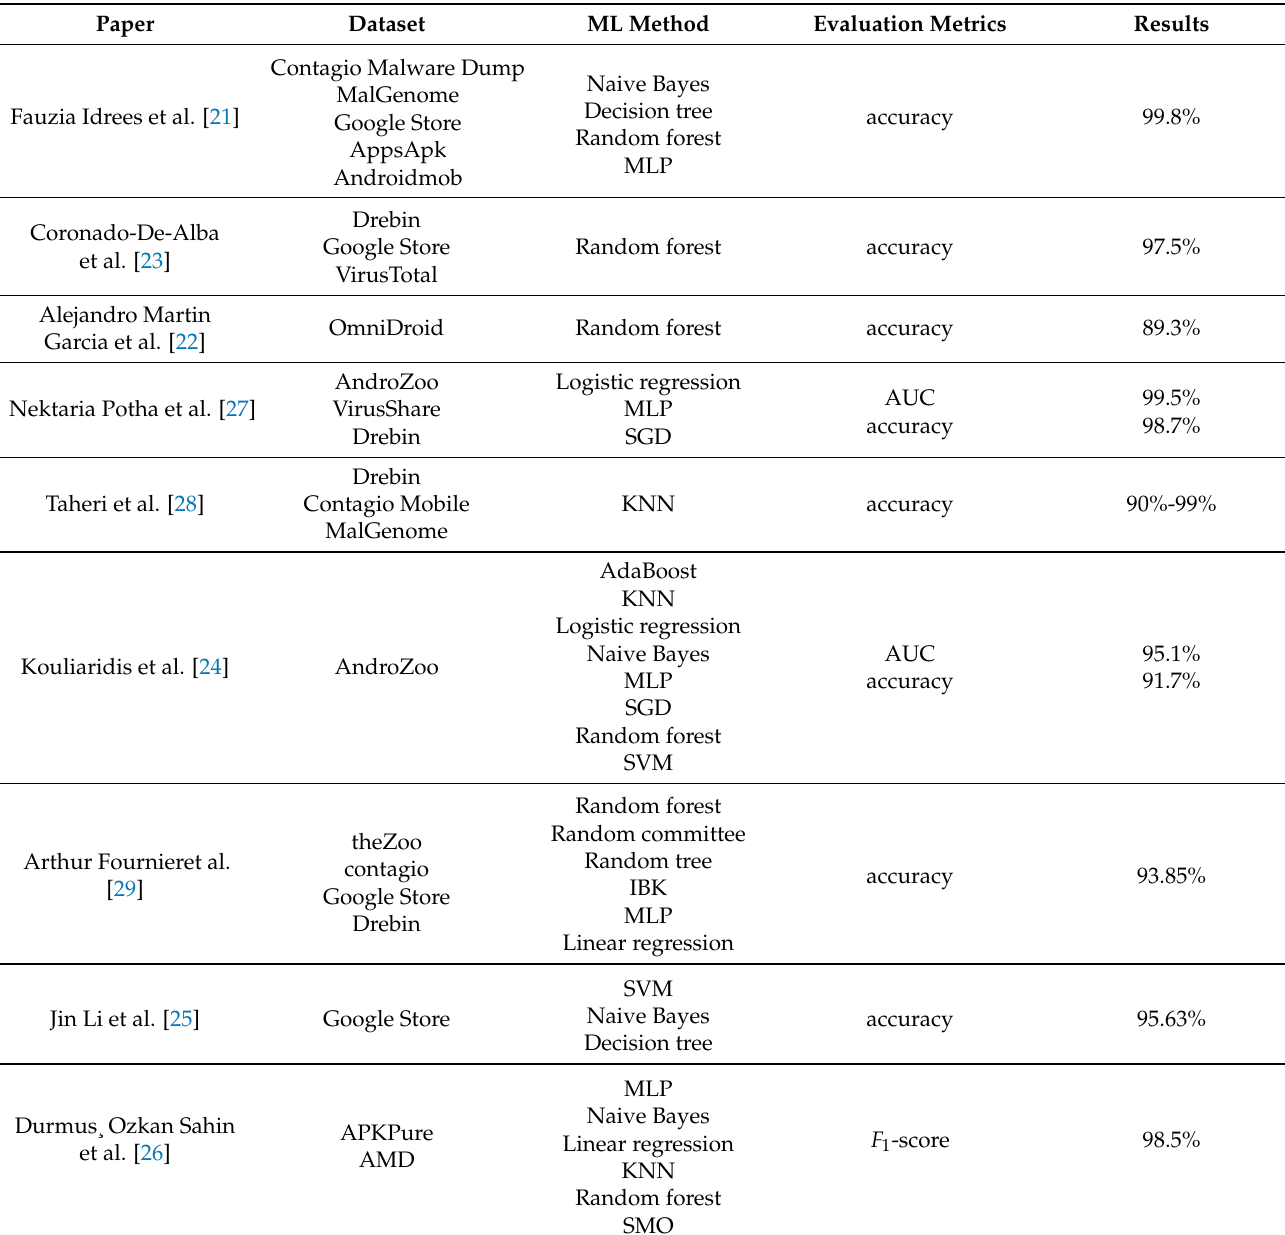
Table 1. Overview of articles on applying machine learning methods for malware detection based on static